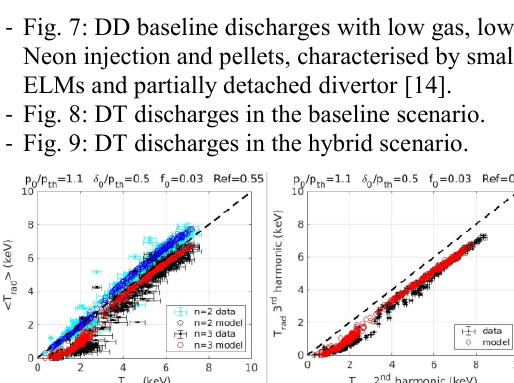
Fig. 7. Subset of JET Deuterium (DD) discharges with low gas, low Neon injection and pellets (pulse numbers: 96990, 96992, 96993, 96994, 96996, 96998, 96999). Comparison between data and model, for perturbation parameters: f 0 = 0.03, p 0 /p th = 1.1,  /p th = 0.5. Left: central ECE radiation temperature vs LIDAR central temperature (both averaged over a region covering 10% of the minor radius around the centre). Right: 3 rd harmonic vs 2 nd harmonic central radiation temperatures. Error bars are also shown.